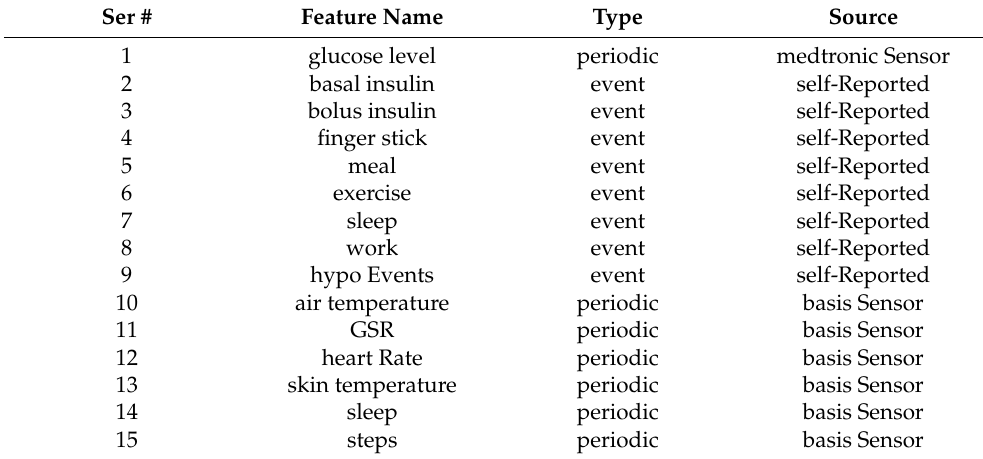
Table 2. Feature details in Ohio T1DM